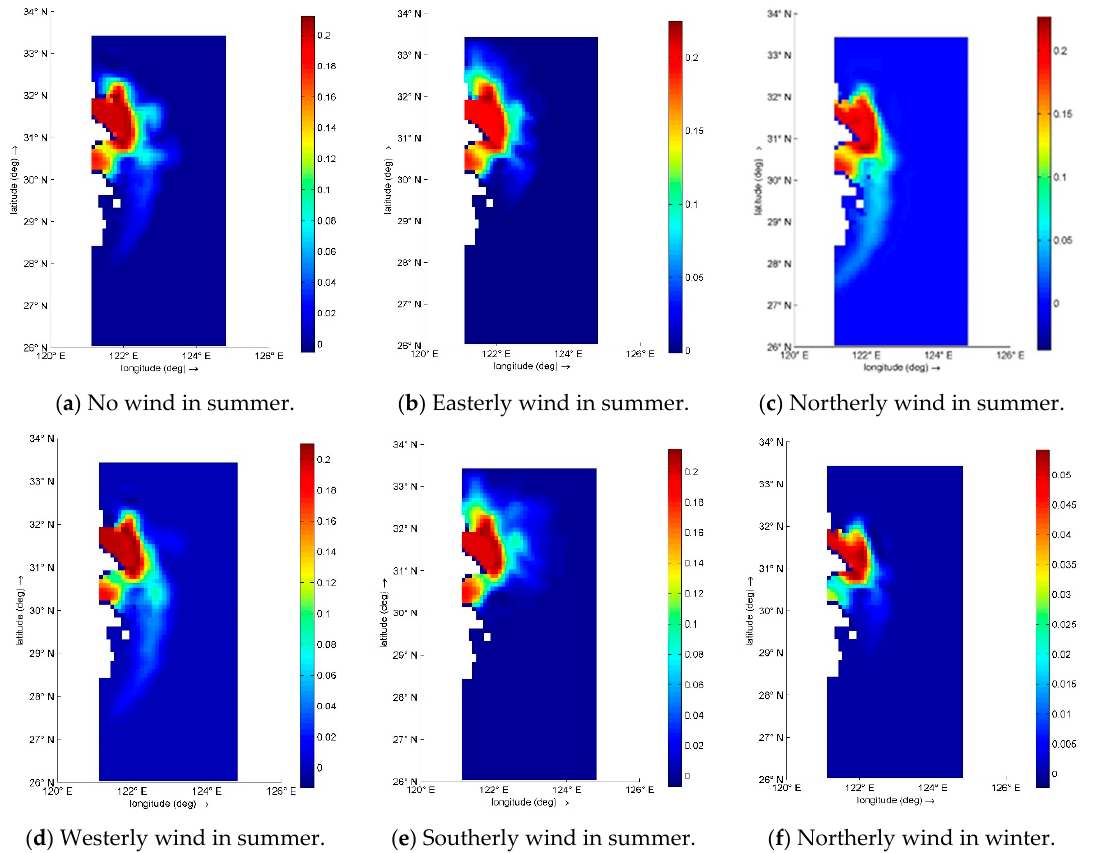
Figure 12. Suspended sediment diffusion of the Yangtze River delta under no wind ( a ), easterly wind ( b ), northerly wind ( c ), westerly wind ( d ), and southerly wind ( e ) in summer and northerly wind ( f ) in winter (unit: g/L).